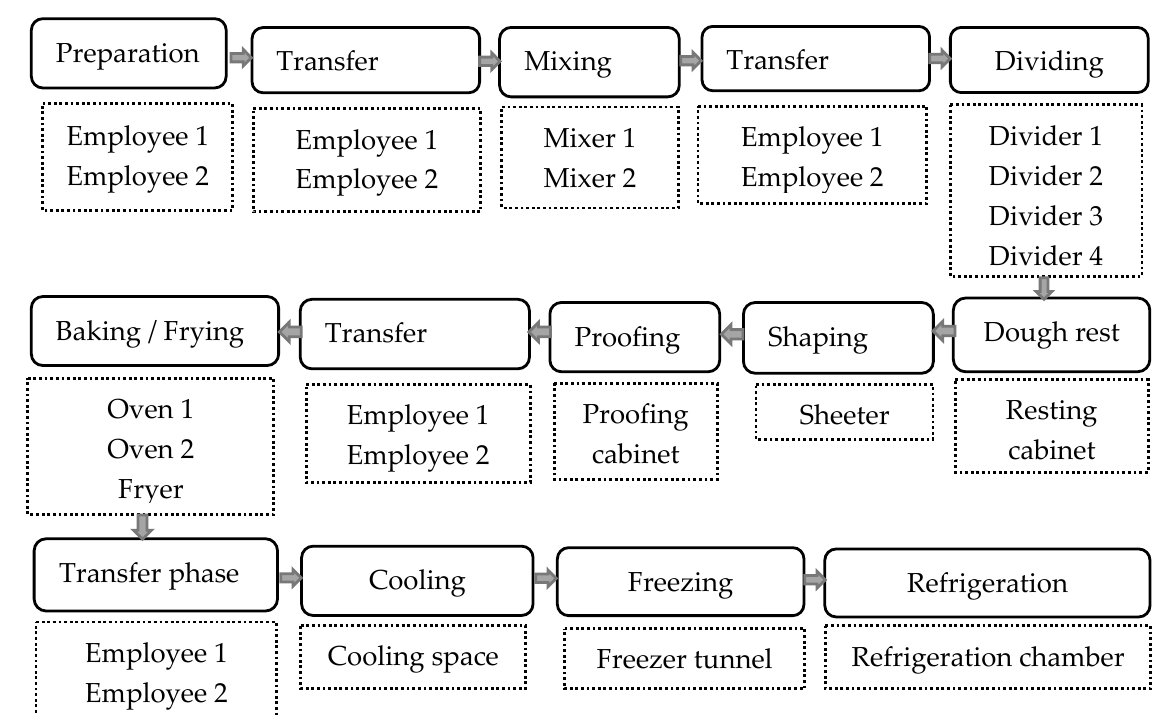
Figure 1. Production line of a bakery with processing tasks (-) and resource alternatives (…) to perform the tasks.